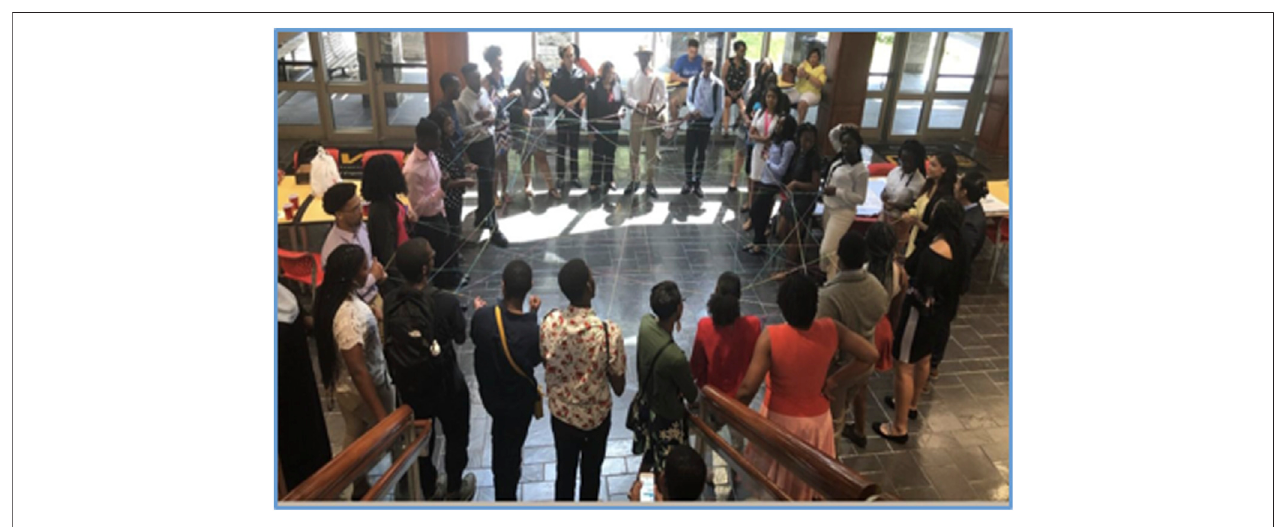
FIGURE 3 | VCU-LSAMP Closing community building